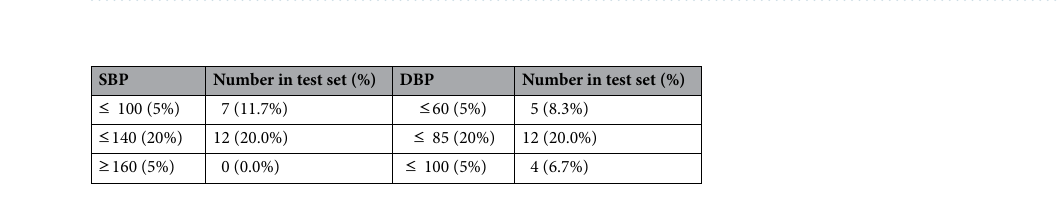
Table 2. Blood pressure distribution in the test